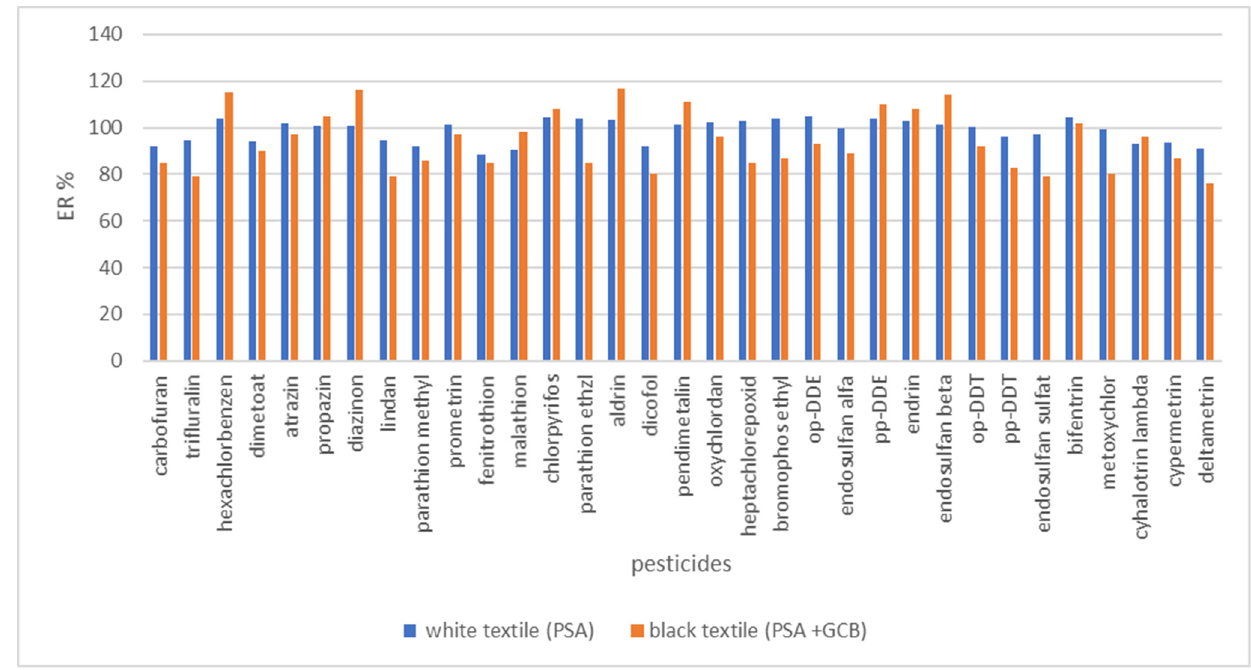
Figure 2. Extraction recovery (ER) of pesticides depending on the type of textile used and the selected cleaning sorbent.